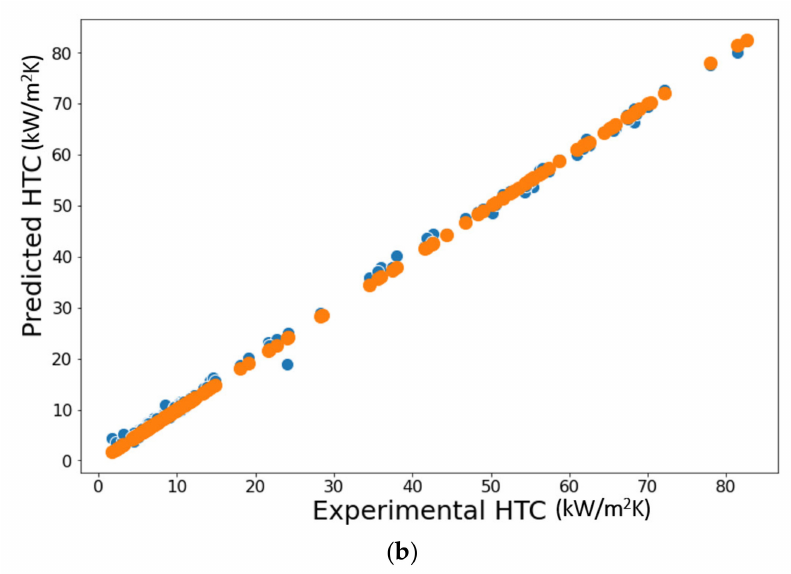
Figure 7. Predictions of the proposed model, ( a ) training and testing datasets and ( b ) testing dataset.